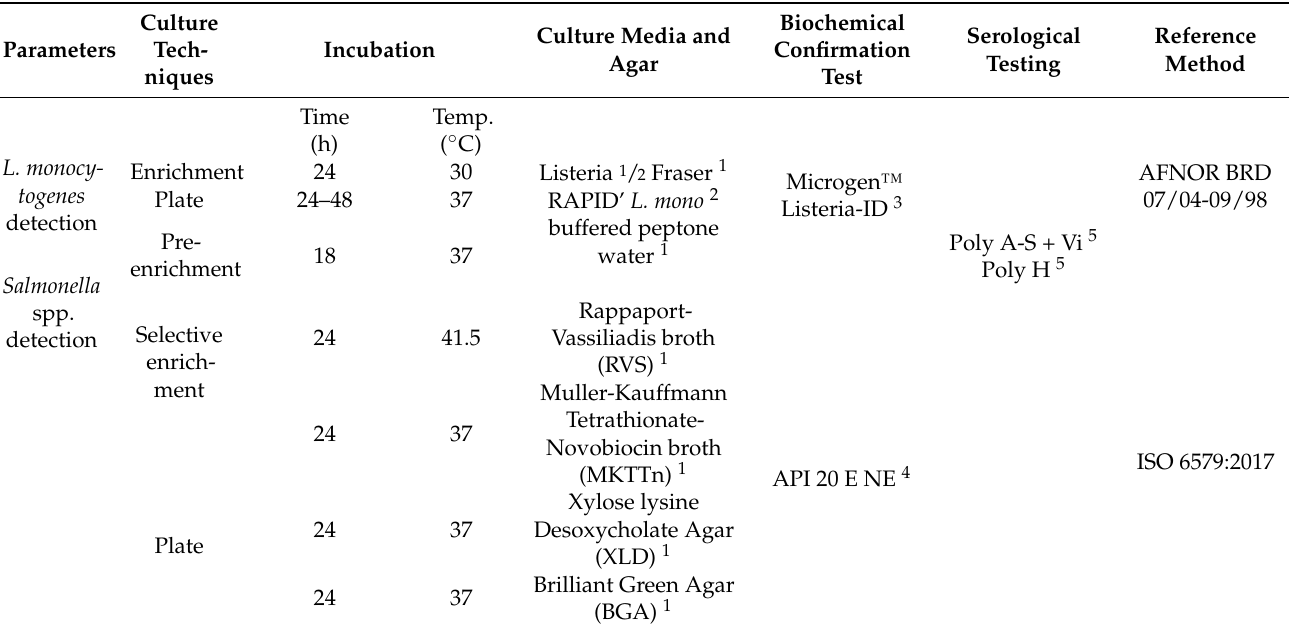
Table 2. Culture techniques (media and agar), incubation conditions, and the biochemical and serological confirmation tests used for the microbiological testing of ready-to-eat food